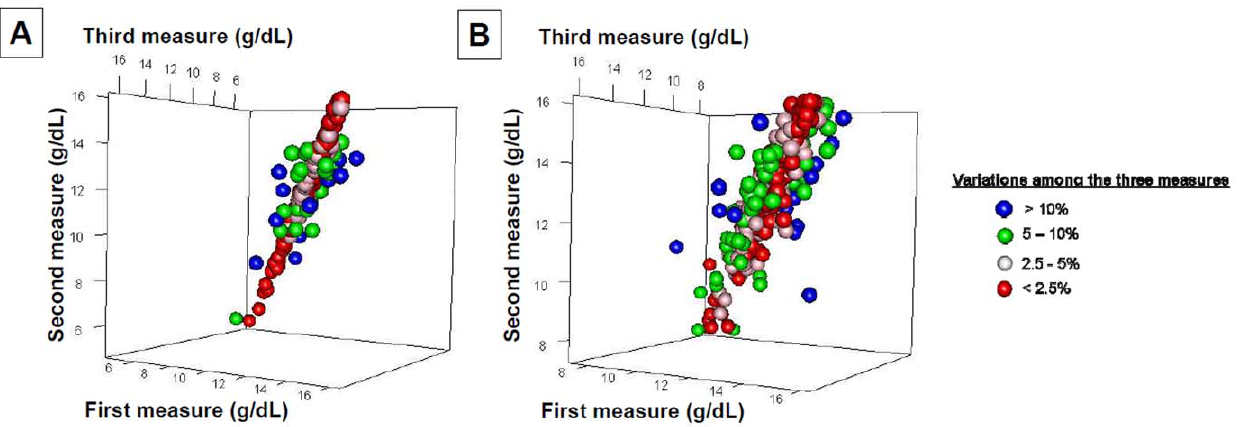
Figure 6. Three-dimensional representation of the variability of the measures obtained with the two monitors. Results for the Pronto- Study are displayed on the panel A and for the Orsense-Study on the panel B. The coordinates of each point are the three consecutive measures. The graphical representation shows that the Orsense TM monitor seems to be associated with a higher variability compared to the Pronto-7 TM . This is confirmed by the fact that variations among the three consecutive measurements was lower than 2.5% in 71% of the cases when using the Pronto- 7 TM monitor but only in 47% of the cases when using the Orsense TM monitor.